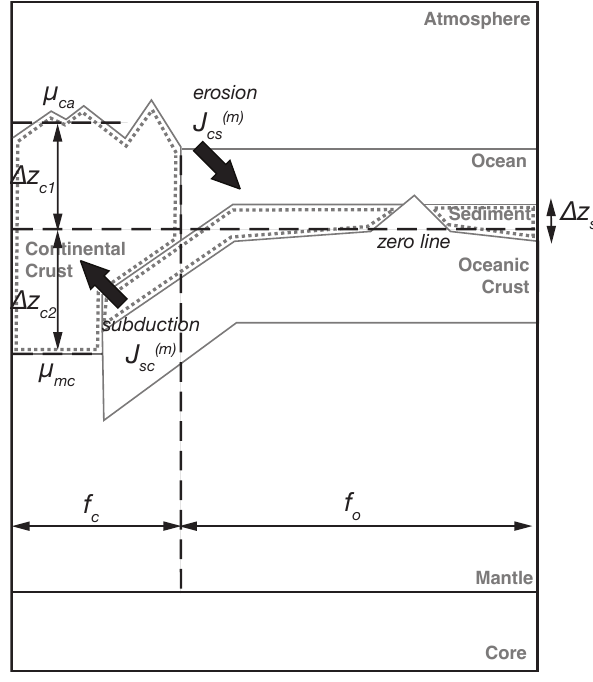
Fig. 8. Top plot: oceanic crust heat flux plotted with solid line (units on left horizontal axis) with varying values for the “Diffusion parameter”, γ . Increasing γ increases the heat flux through oceanic crust. Temperature gradient, the difference in temperature between surface of oceanic crust and upper mantle, plotted with dashed line (units on right vertical axis) with varying values for γ . Increasing γ decreases the temperature gradient. Bottom plot: entropy produc- tion in oceanic crust recycling as a function of γ .